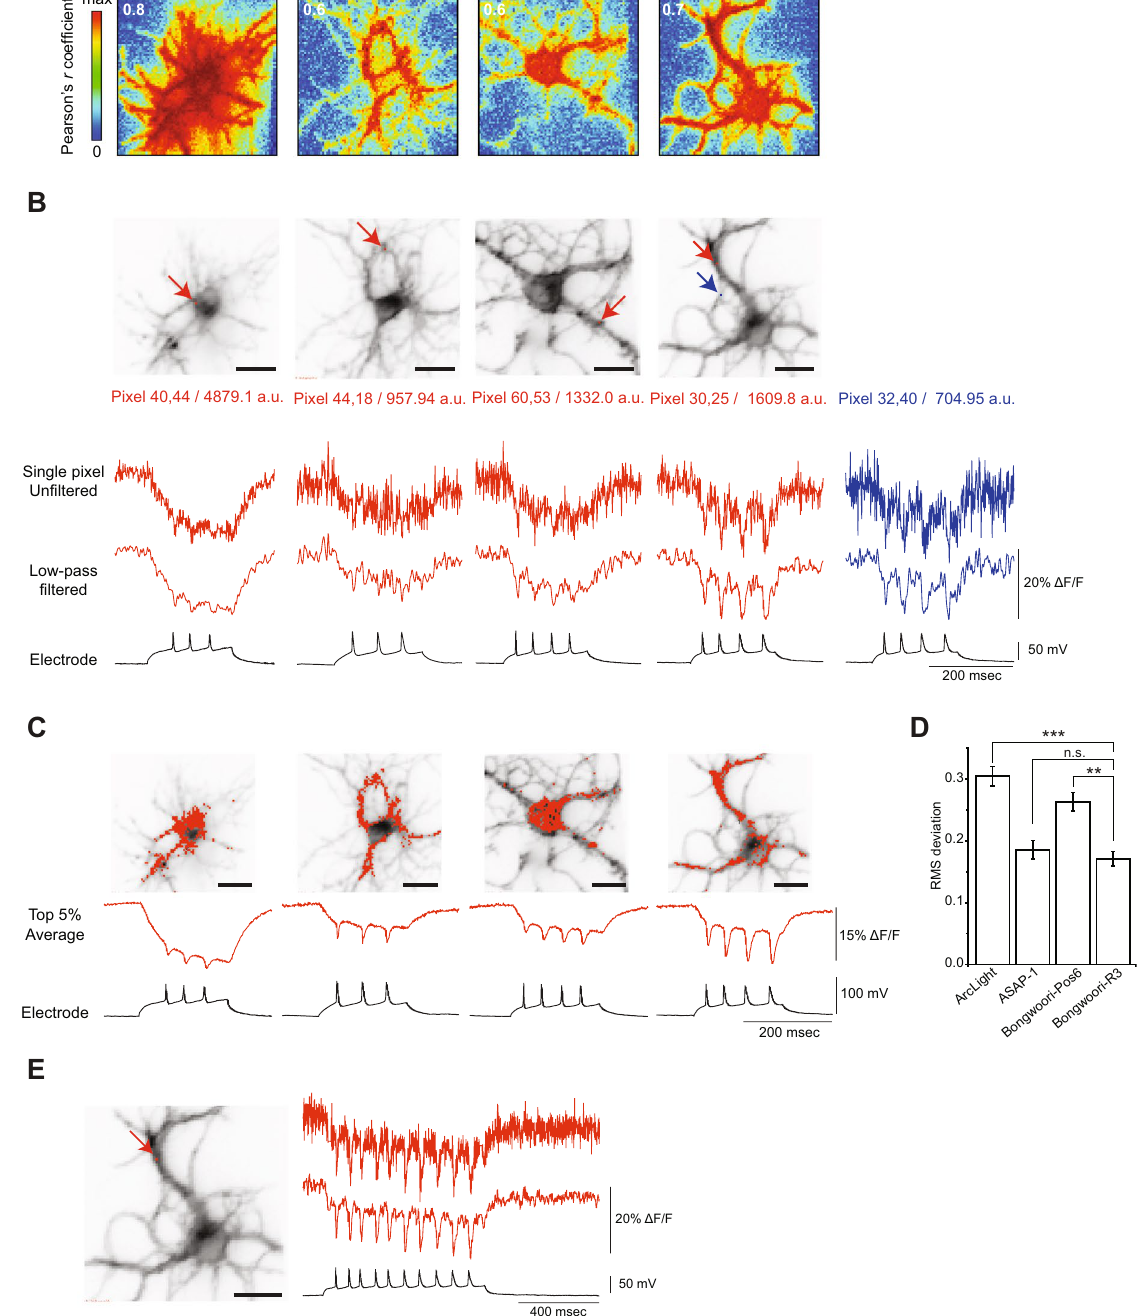
Figure 7. Single trial, single pixel traces exhibiting the highest correlation of fluorescence change to voltage. ( A ) Pearson’s correlation coefficient matrix of the fluorescence to the voltage. The highest coefficient value is indicated in white. ( B ) The red arrows indicate the position of the pixel with the highest correlation coefficient. The blue arrow indicates a pixel with lower fluorescence intensity. Numbers below each image refer to the fluorescence intensities (in arbitrary units, a.u.) of the selected pixels. Pixel signals are shown unfiltered (top) and low-pass filtered (middle). Electrical recording is shown for comparison (bottom). ( C ) Top 5% pixels with the highest correlation coefficient and corresponding average traces. ( D ) Root-mean square deviation of optical traces in ( C ) compared to the voltage signal. ( E ) Bongwoori-R3 signal from single pixel with the highest correlation coefficient. Low-pass Gaussian filter with cut-off frequency of 100 Hz was applied for filtering. Error bars are standard error of the mean. Asterisks in ( D ) indicate statistical significance ( * p < 0.05, ** p < 0.01, *** p < 0.001 and n.s.: not significant). Scale bars: 20 µ